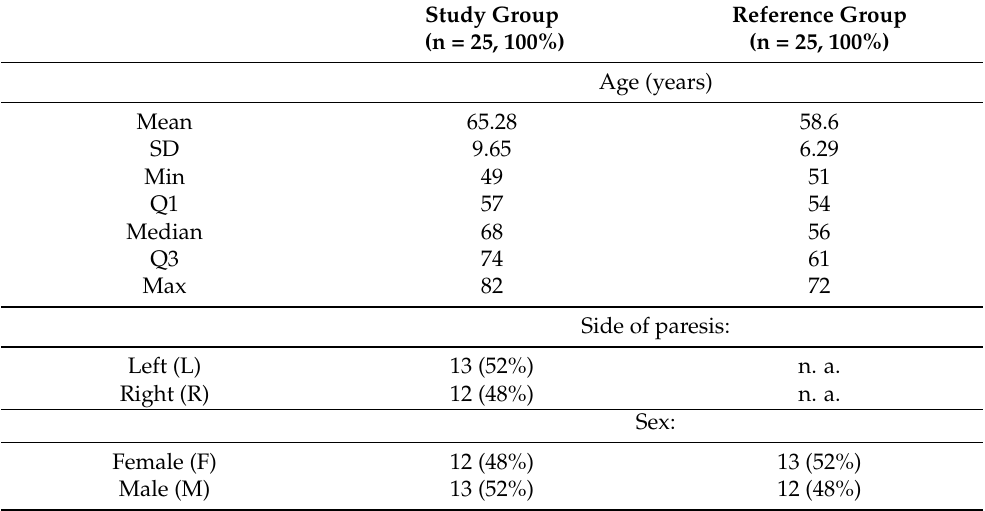
Table 1. Clinical summary of the